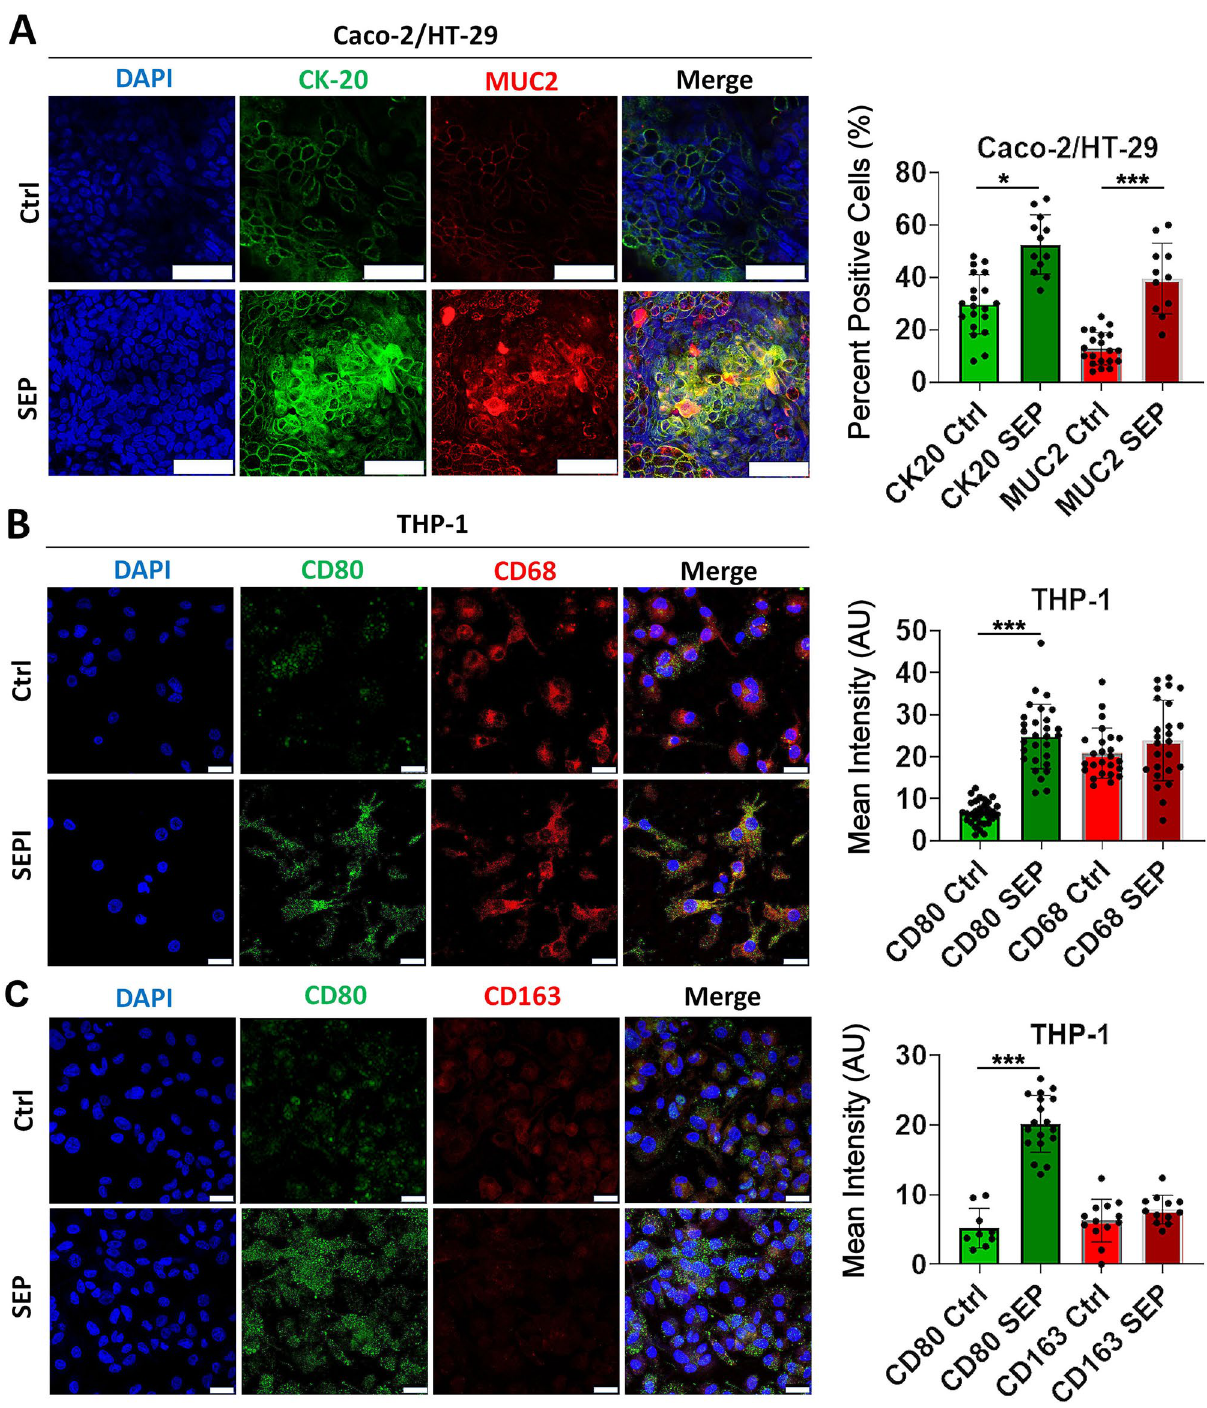
Figure 5. Sepiapterin promotes MUC2 and Cytokeratin-20 expression in Caco-2:HT-29 epithelial layer and the emergence of M1-like phenotype in naïve THP-1 macrophages in 3D Flipwell co-cultures. ( A ) (Left) Confocal images of Caco-2:HT-29 cells co-cultured with THP-1 cells in the 3D Flipwells and stained for CK20 (green) and MUC2 (red). Cytokeratin staining is very pronounced in the areas surrounding mucus production as indicated by MUC2 expression. Scale bar represents 50 µm. The original raw images are included in Supplementary Information file. (Right) Percent positive cells for CK20 and MUC2. ( B ) (Left) Confocal images of THP-1 cells cocultured with Caco-2:HT-29 in the 3D Flipwells and stained for Pan Macrophage marker CD68 (red) and CD80 (green). Pan Macrophage marker CD68 is present in both SEP treated and untreated control samples. CD80, typical of the M1 macrophage phenotype, is more pronounced in SEP treated sample with long pseudopods extending outward typical of the M1 phenotype. (Right) Mean intensities of CD68 and CD80. ( C ) (Left) Confocal images of THP-1 cells cocultured with Caco-2:HT-29 in the 3D Flipwell and stained for Pan Macrophage marker CD80 (green) and CD163 (red) to validate phenotypic polarization toward M1 phenotype and away from M2 phenotype. Scale bar represents 25 µm. The original raw images are included in Supplementary Information file. (Right) Mean intensity of CD80 and CD163. Error bars: mean ± STDEV. *p < 0.05; ***p <